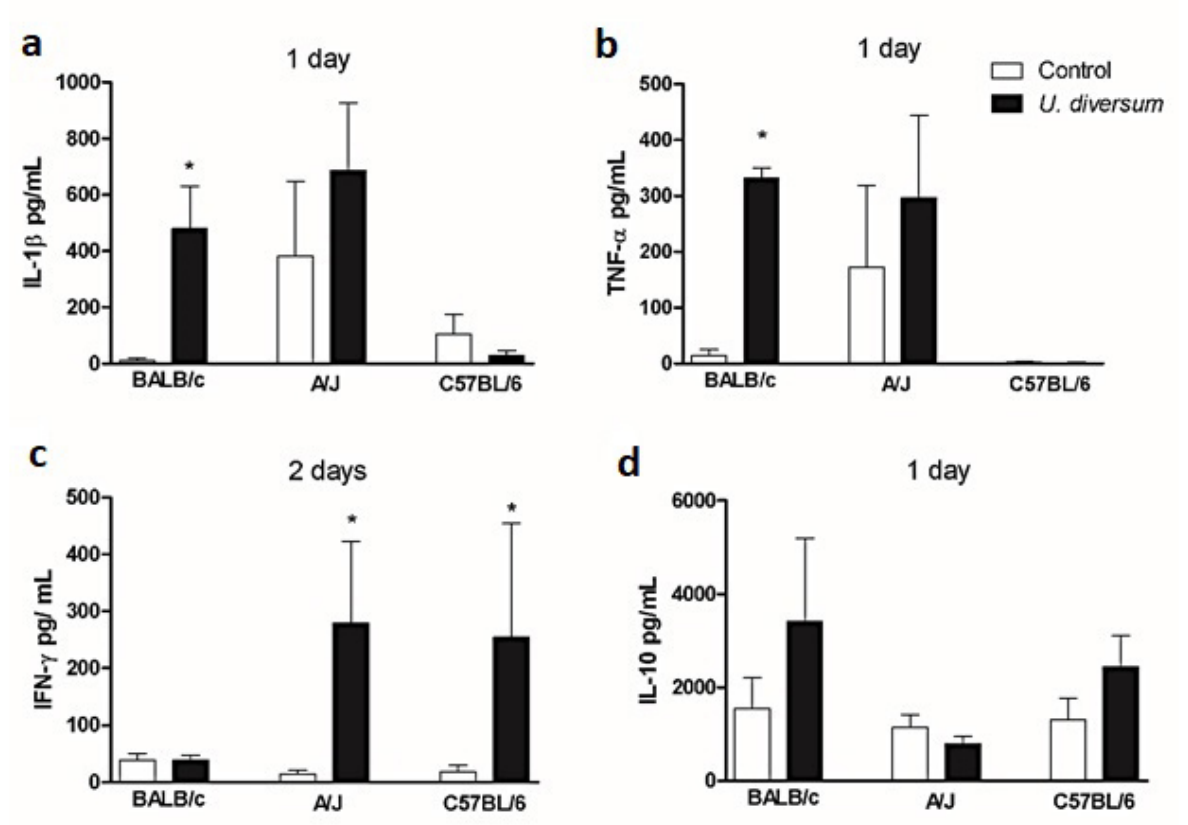
Figure 3. Pulmonary response cytokines. Mice were infected intratracheally by 10 4 CCU of U. diversum and euthanized 1 or 2 days after infection. The BALs were centrifuged and the supernatant of BALs were used for measurement of cytokines (IL-1β, TNF-α, IFN-γ and IL-10) by ELISA. ( a ) IL1- β; ( b ) TNF-α; ( c ) INF-γ; ( d )